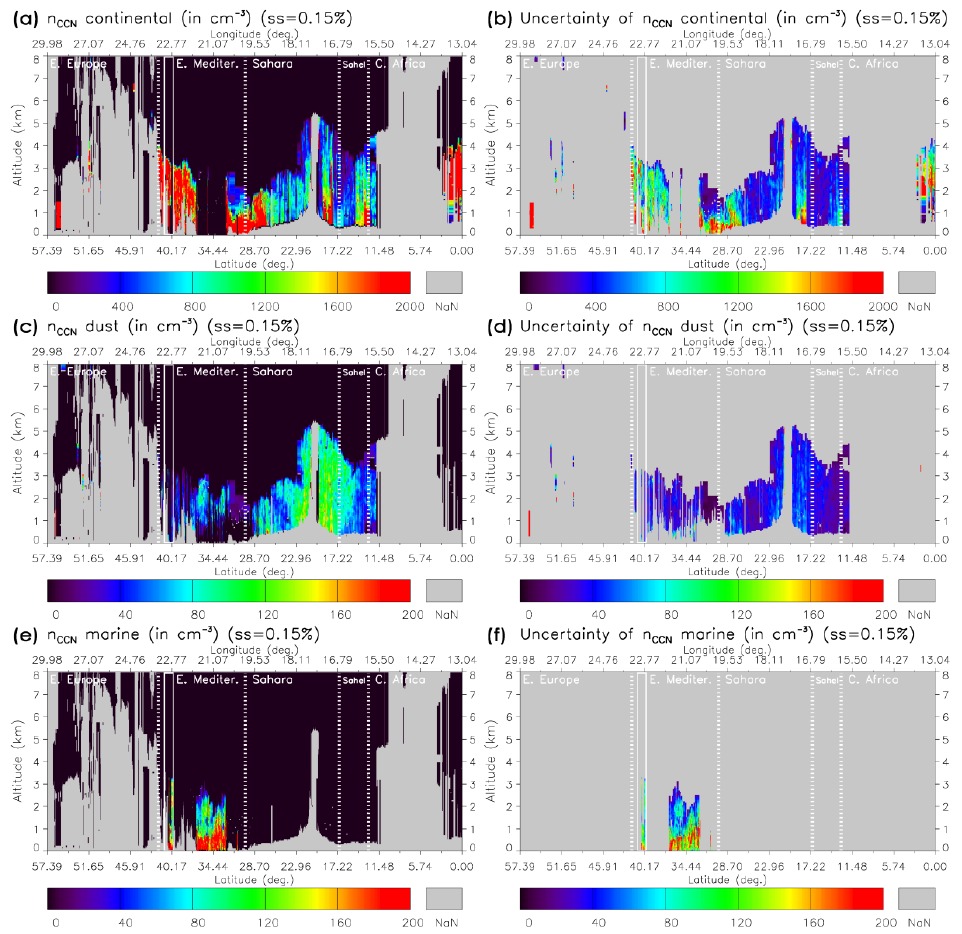
Figure 7. Vertical cross sections of CALIPSO-derived CCN concentrations, and the corresponding uncertainties (using error propagation), at a supersaturation of 0.15% for continental (a, b), dust (c, d), and marine aerosols (e, f). Different scale is used for continental CCNs (values up to ten times larger than dust and marine CCNs).